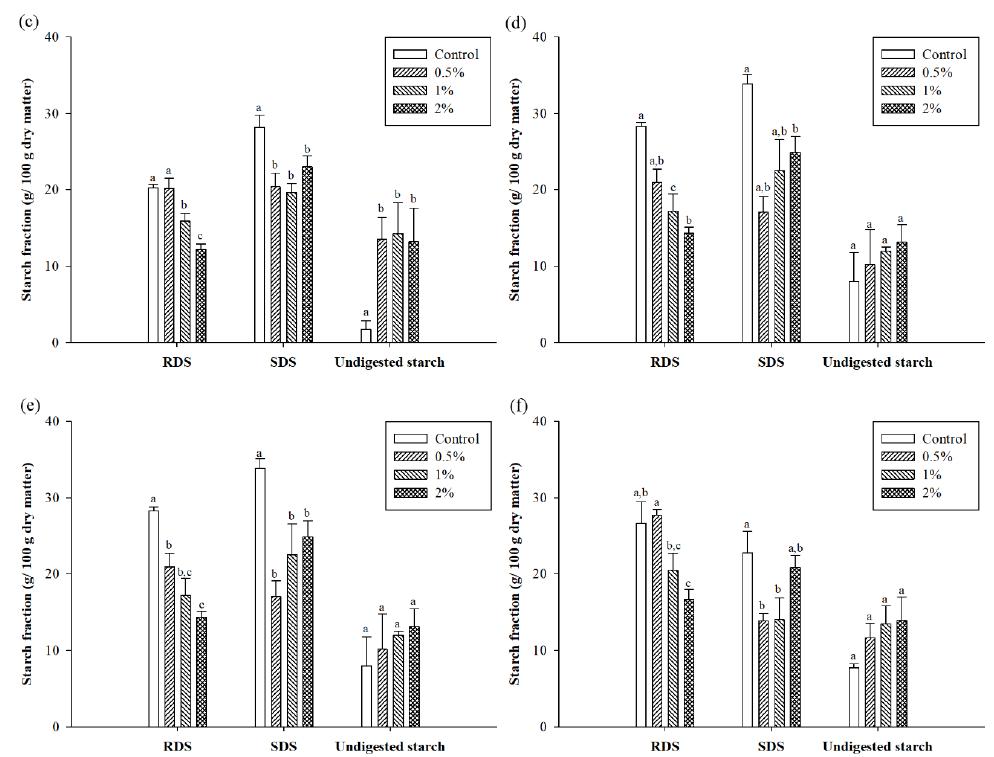
Figure 3. Starch fraction after in vitro digestibility of ( a ) potato flour, ( b ) rice flour, ( c ) glutinous rice flour, ( d ) wheat flour, ( e ) corn flour, and ( f ) cassava flour when in combination with the different concentration of CTE. The value of 0.5%, 1%, and 2% ( w / v ) represent the concentrations of CTE, respectively. The results are expressed as mean ± standard error of the mean (SEM), n = 4. The different letters denote statistically significant differences in mean values. ( p < 0.05) Mean values with the same superscript letters (a, b or c) were similar and no statistically significant differences were observed for these samples. RDS: rapidly digestible starch; SDS: slowly digestible starch. Table 3. Correlation coefficients calculated between the concentrations of Clitoria ternatea (CTE) and undigested starch contents after in vitro digestion. Potato Rice Glutinous Rice Wheat Corn Cassava CTE